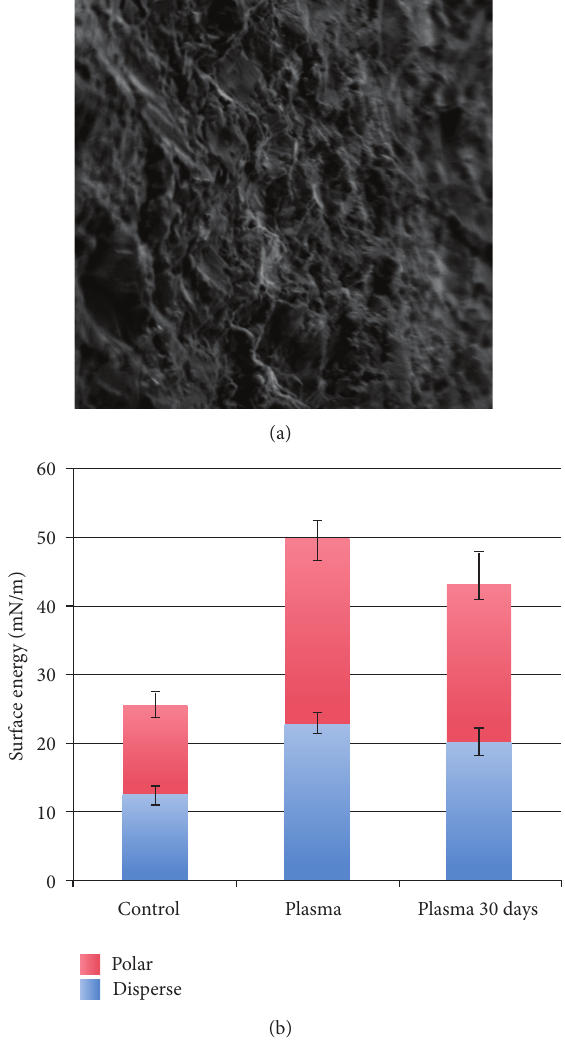
F 1: (a) Scanning electron microscopy micrograph (1000X) of